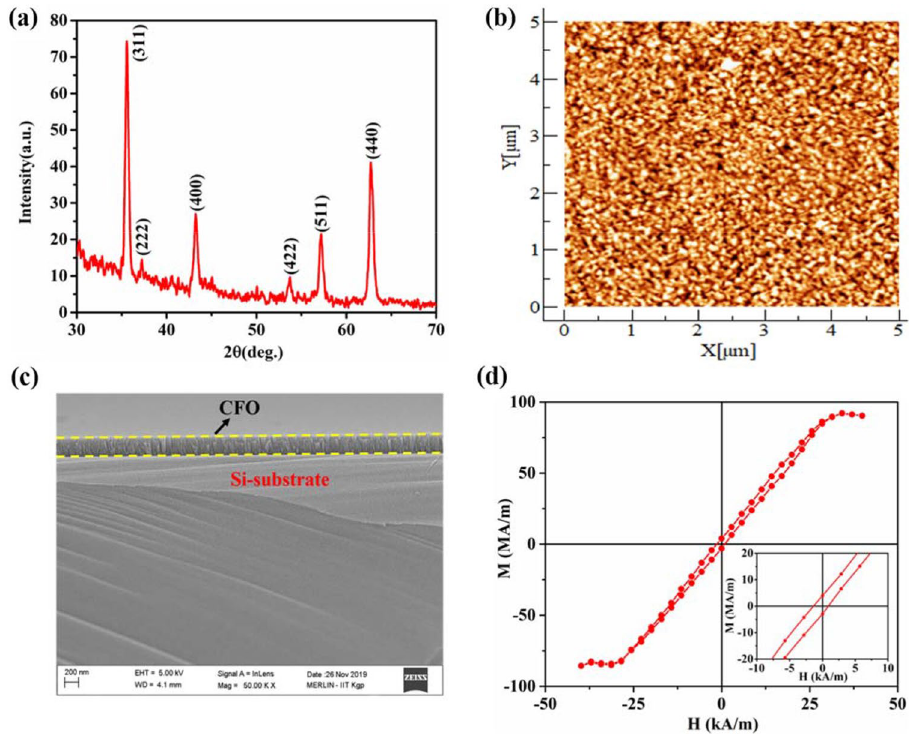
Figure 1. ( a ) GIXRD pattern of CFO film. ( b ) AFM image of CFO film over (5 μm × 5 μm) scan area. ( c ) Cross- sectional FESEM view of CFO/Si heterojunction. ( d ) The M–H curve of CFO film at 300 K.The magnified views of the hysteresis loop is shown at the